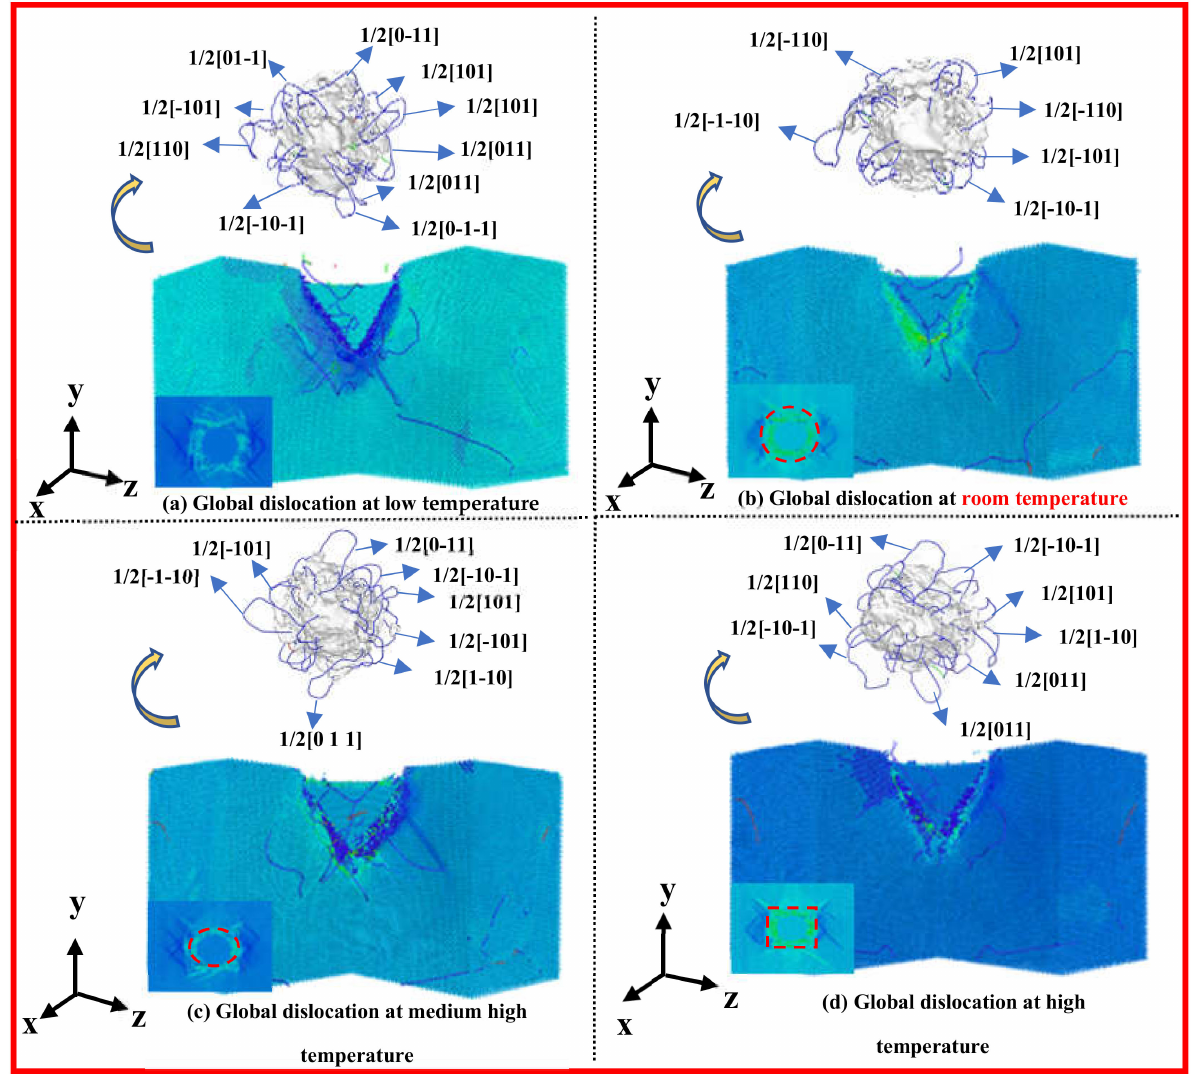
Figure 5. Dislocation panoramic view and stress-strain cross-section and overhead